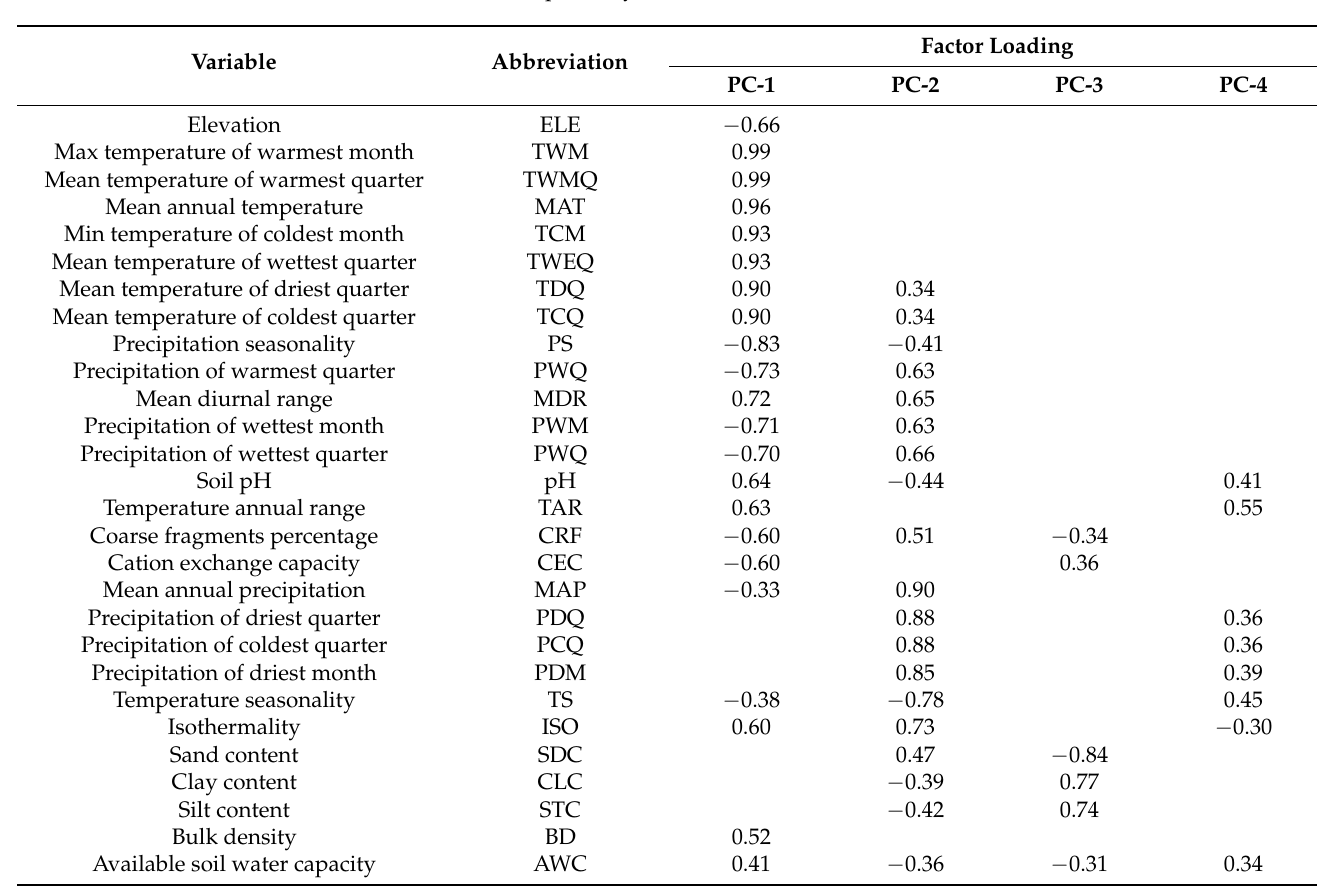
Table 2. Environmental predictors used to develop spatial distribution of C:N:P ratios in Schrenk’s spruce forest, and principle components analysis (PCA) of these predictors associated with soil stoichiometry. Eigenvalues (and percent of variance) were 12.09 (43.00%), 7.72 (25.75%), 3.01 (10.05%) and 2.14 (7.14%),